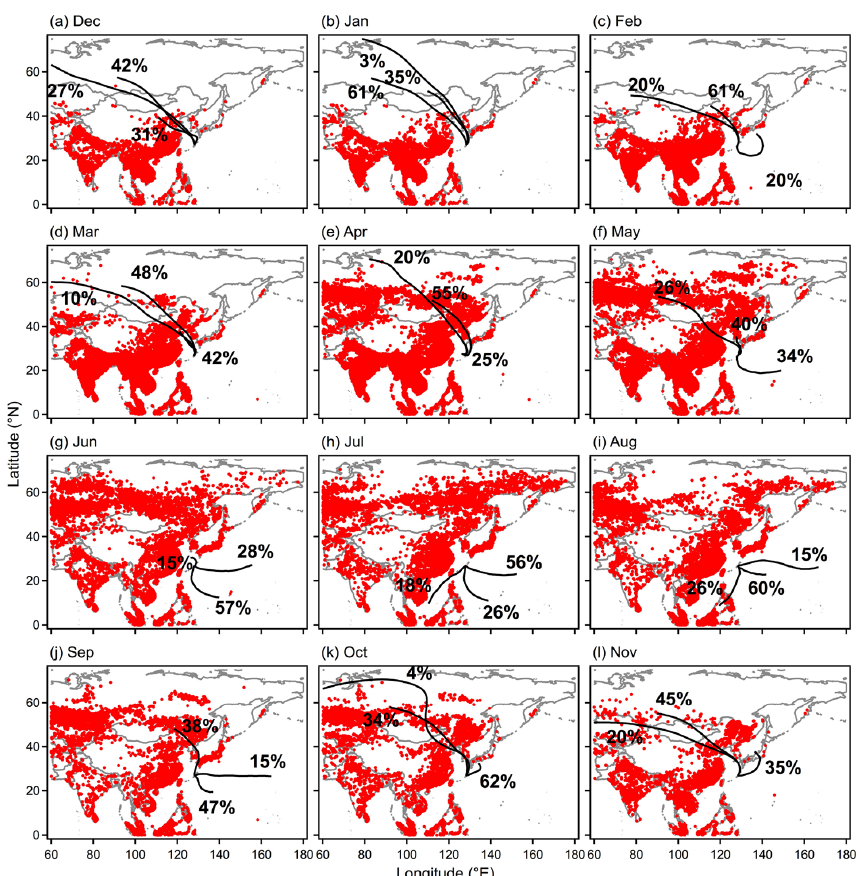
Figure 2. Monthly distribution of air mass origins to Cape Hedo, Okinawa, shown by clusters of 5-day backward trajectories arriving at 500ma.g.l. during December 2009–November 2011. The numbers in each panel indicate the percentages of daily trajectories in the month with such origins. Fire spots in East Asia in each month of the same period are also